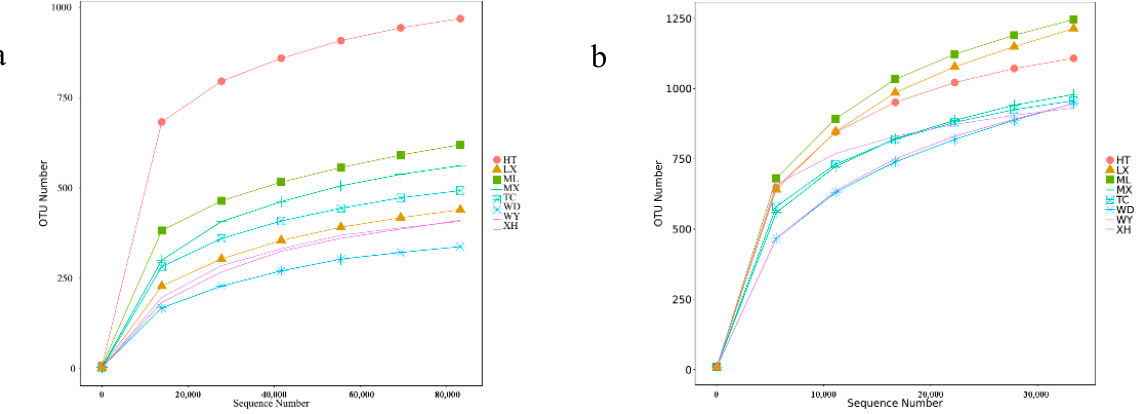
Figure 2. Rarefaction curves base on pyrosequencing of endophytic fungi ( a ) and bacteria ( b ) for each sample. Table 2. Community diversity of fungi and bacteria.